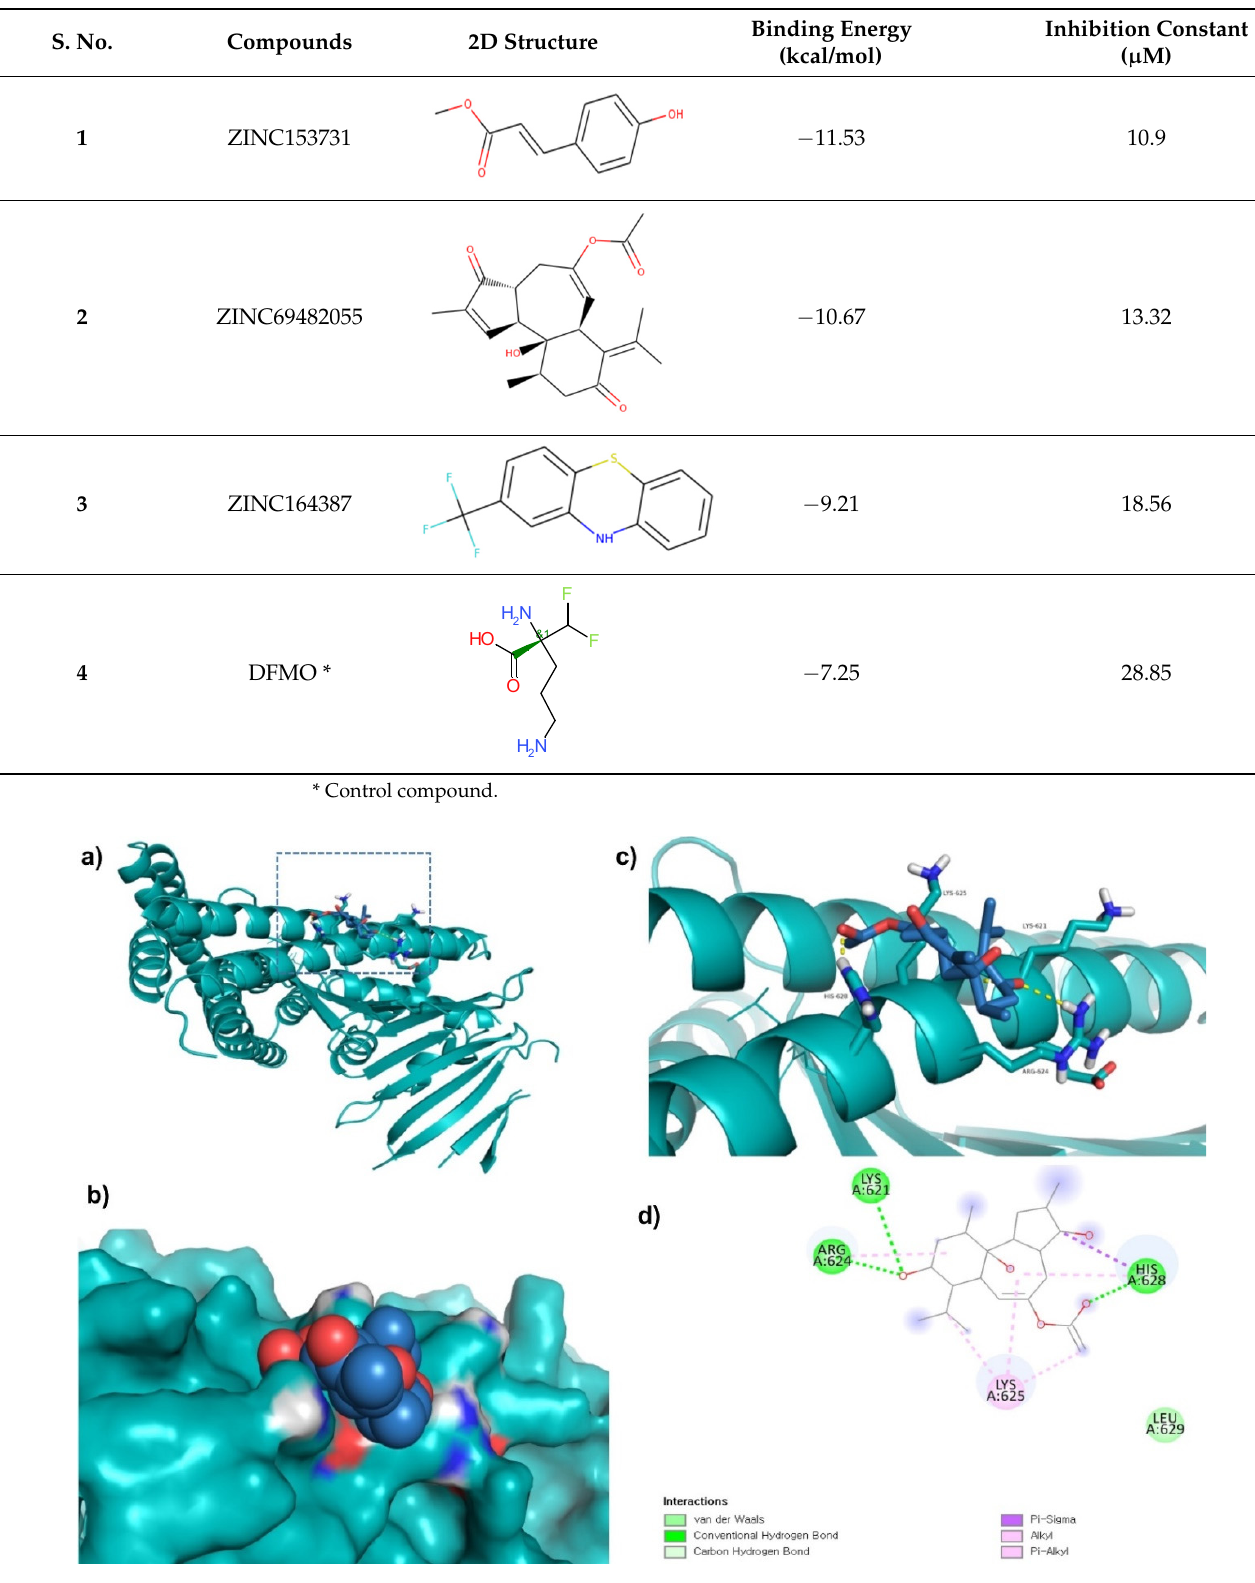
Figure 2. Visualization and surface view of ZINC69482055 in active site of CagA protein ( a , b ). Three-dimensional ( c ) and 2D ( d ) view of CagA residue interacting with ZINC69482055.